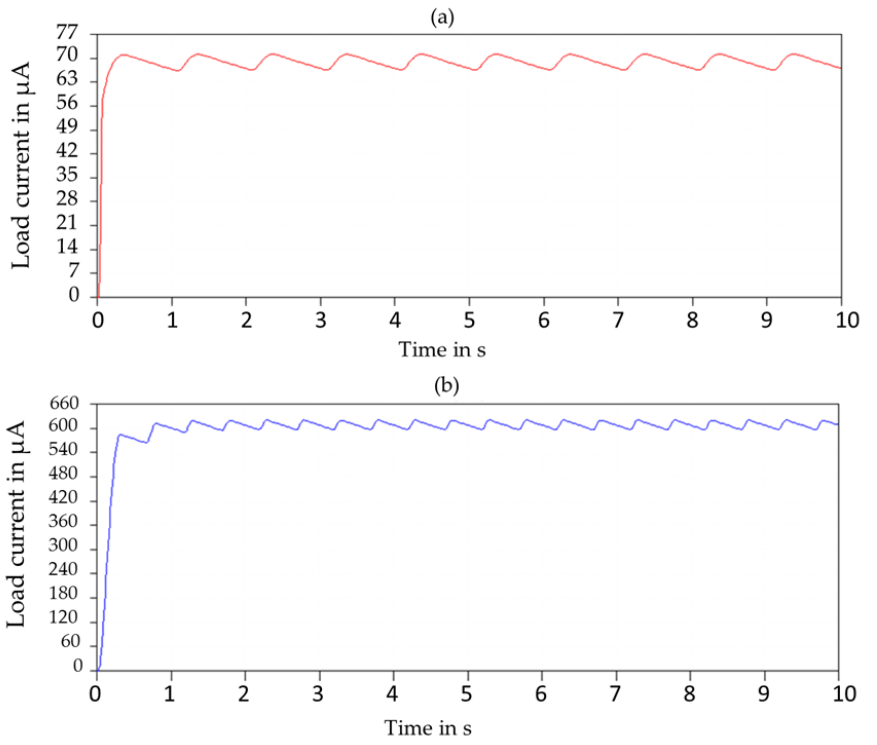
Figure 7. Simulated output current flowing through the load ( a ) before the added series resistance ( b ) after the added series